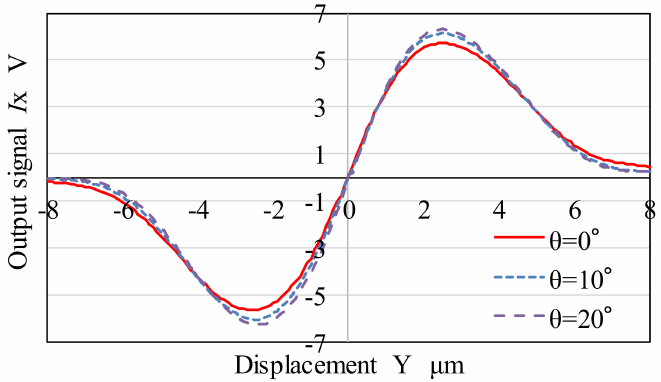
Figure 4. Experimentally measured values of I X for angles θ = 0 ◦ , 10 ◦ and 20 ◦ (displacement of the stylus shaft along Y-axis = ± 2.5 µ